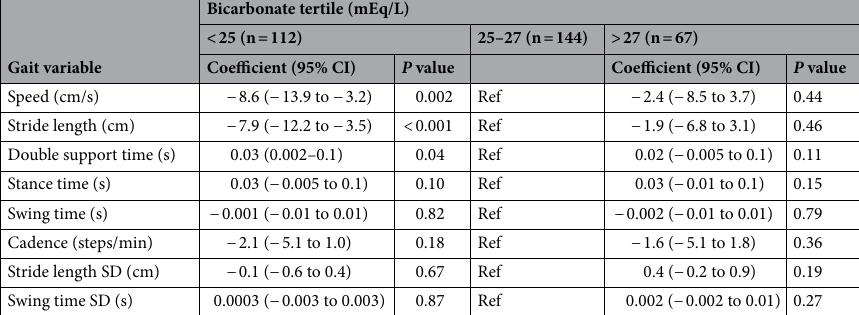
Table 2. Associations of serum bicarbonate tertiles with gait variables. Multivariable linear regression adjusting for age, sex, race, education, smoking status, body mass index (BMI), number of comorbidities, number of medications, diuretic use, diagnosis of neuropathy, cardiovascular disease, hypertension, diabetes, emphysema or chronic obstructive pulmonary disease (COPD), blood urea nitrogen (BUN), and estimated glomerular filtration rate (eGFR) was performed. The reference group was serum bicarbonate 25–27 mEq/L (middle tertile). Ref reference group, SD standard deviation. N = 323 total.